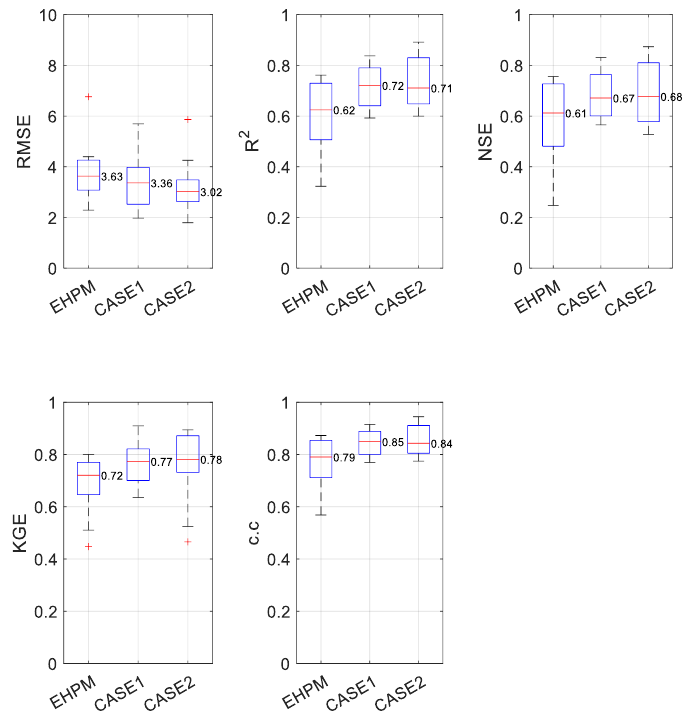
Figure 8. Boxplots for streamflow prediction performances of the benchmark model (EHPM), the separately learned LSTM (CASE 1), and the integrally learned LSTM (CASE 2). Note that the red lines are median values, the blue boxes represent the first and third quartile, the whiskers represent the range between maximum and minimum values, and the red cross markers are the outlier. The value on the side of a box is its median value.